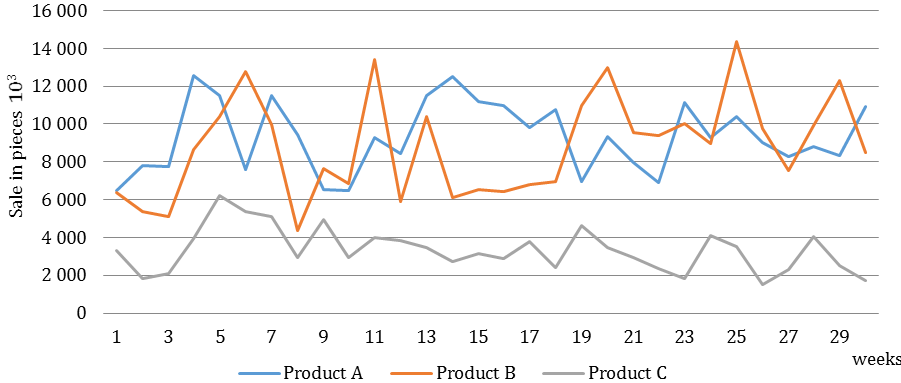
Figure 1: Real sales of the products A, B,